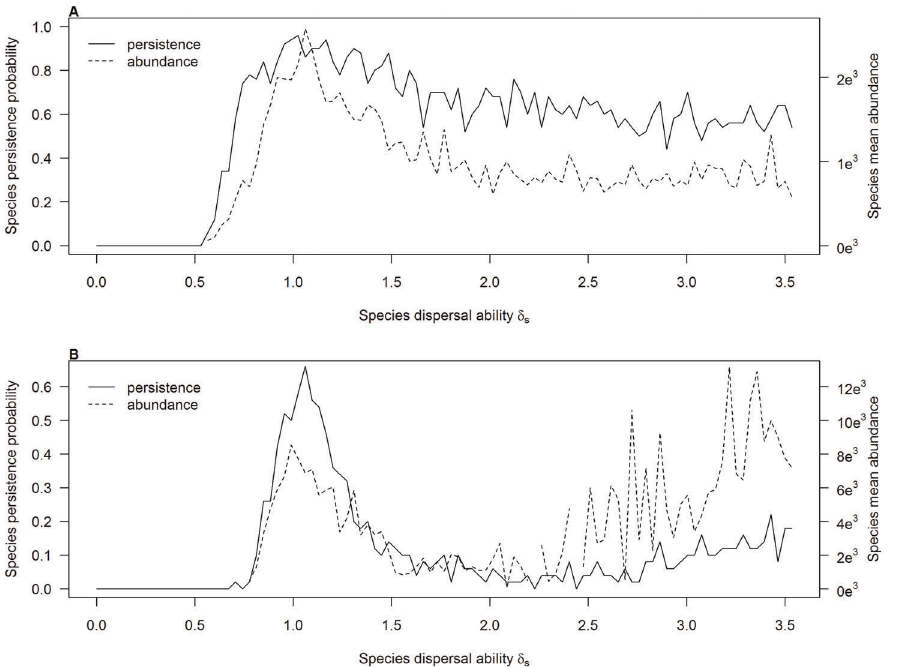
Figure 5. Species persistence and mean abundance as a function of their dispersal ability. On the left y-axis (continuous line) is represented the species persistence probability (proportion of replicates in which the species has survived) while the right y-axis (dashed line) shows the species mean abundances (computed only on the replicates in which the species has survived). (a) Generalist species ( s s =0.5) with very high adult survival rate ( y s =0.95), in the presence of a low disturbance rate (T=0.01) in an uncorrelated environment ( a =0). (b) Generalist species ( s s =0.5) with high adult survival rate ( y s =0.5), in the presence of a medium disturbance rate (T=0.1) in an uncorrelated environment ( a =0).